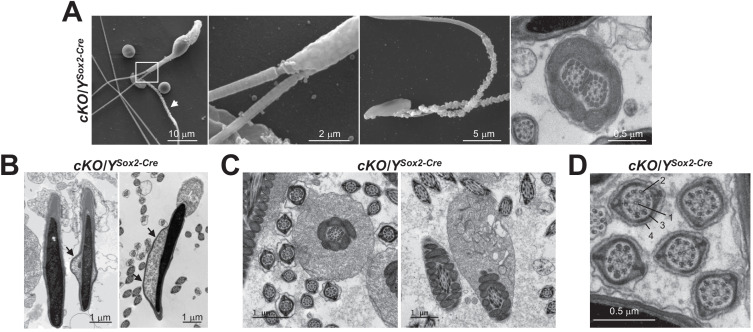
Evaluation of sperm structure within testes of cKO/YSox2-Cre animals.(A) Examples of cKO/YSox2-Cre sperm exhibiting two axonemes (SEM). Left panel: Sperm with two axonemes. Boxed area is shown in higher magnification. Middle panel: Sperm with two axonemes and ruptured midpiece. Right panel: TEM showing sperm with two axonemes, as indicated by the same orientation of dynein arms. (B) Head malformations as detected in TEM on testes sections are indicated by arrows. Arrows point at cytoplasmic pockets. (C, D) No major structural deficiencies were detected via TEM on testes sections in the midpiece (C) and the tail (D). 1=inner microtubule doublet of the axoneme (2); 2=outer microtubule doublet of the axoneme (9); 3=fibrous sheath; 4=plasma membrane.